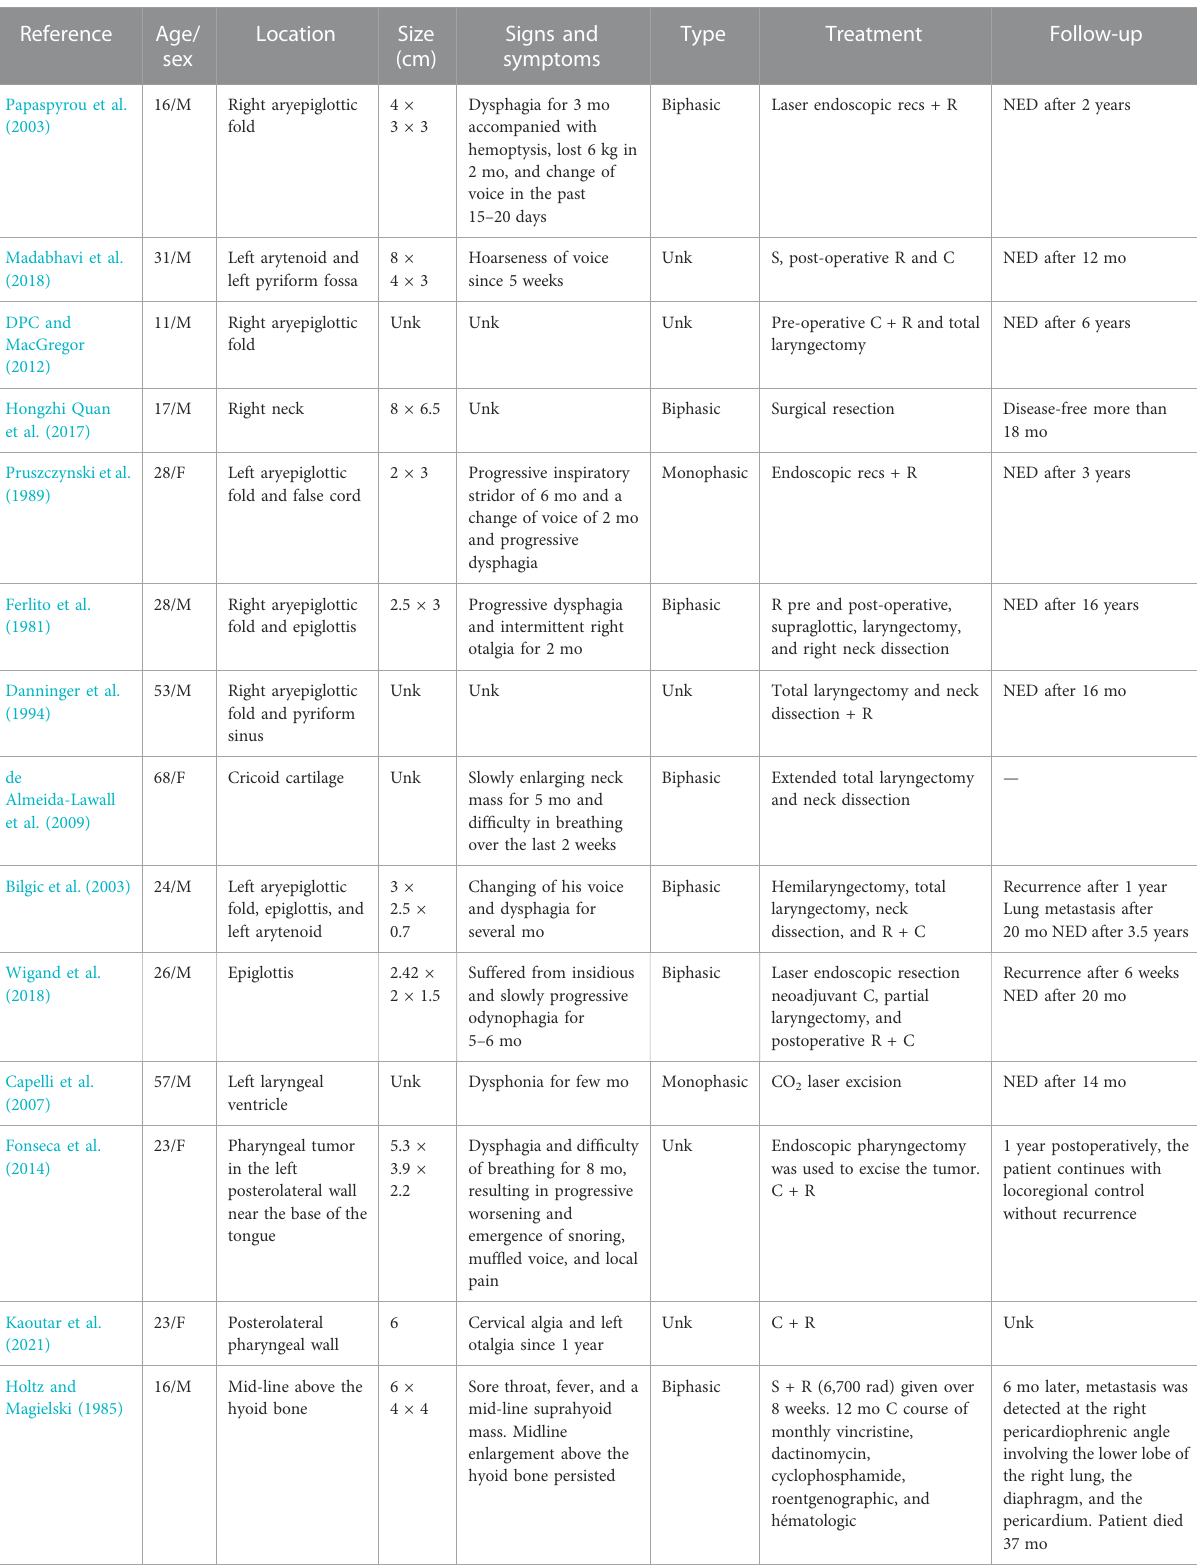
TABLE 1 Reported cases of laryngeal and pharyngeal synovial